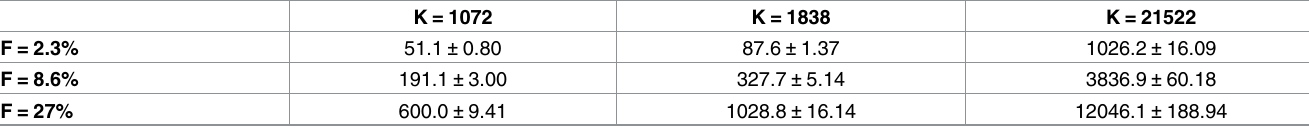
Table 1. Effect of handling time on estimated intake when concentrations in thermal paper are low. K = 1072